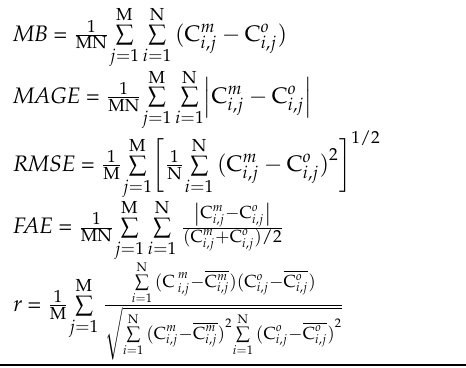
Table 4. Calculation formulae for the primary statistical parameters.